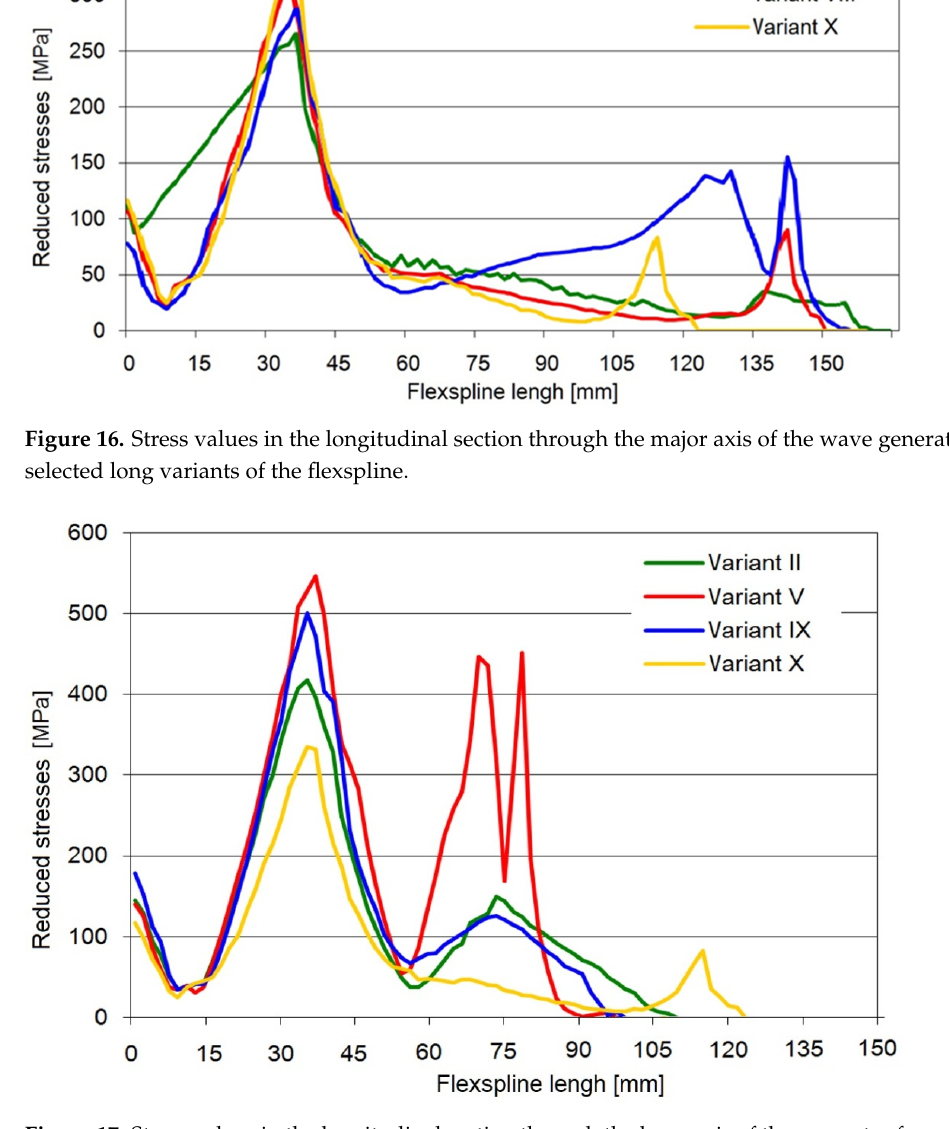
Figure 17. Stress values in the longitudinal section through the large axis of the generator for se- lected short variants of